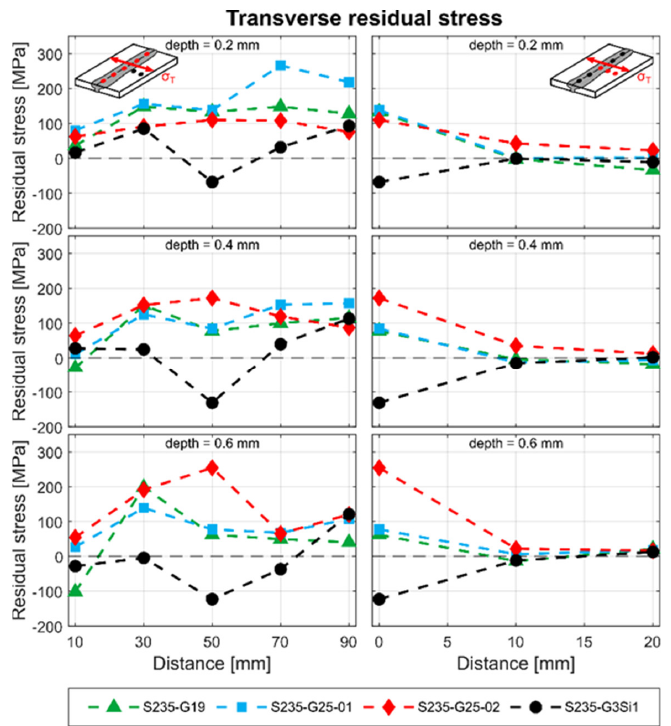
Figure 11. Residual stress measurement using the hole-drilling method and electronic speckle pattern interferometry. Measurements show the transverse residual stress along the weld seam (graphs on the left) and in the base material (graphs on the right).